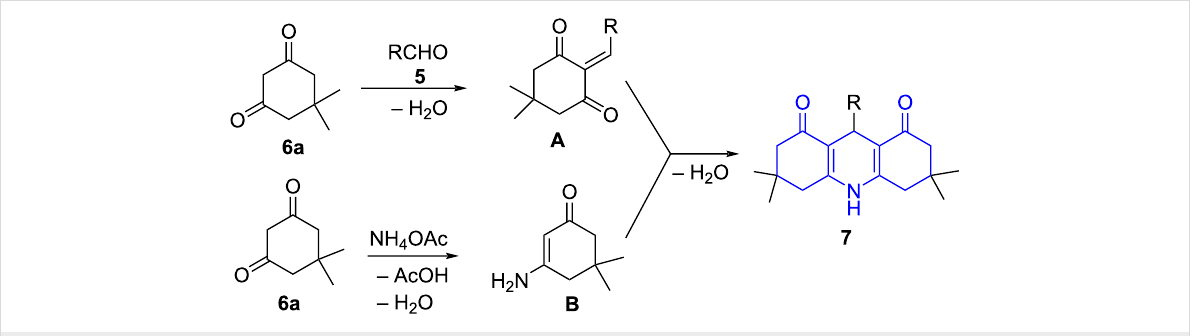
Scheme 2: Proposed mechanism for acridinedione synthesis.